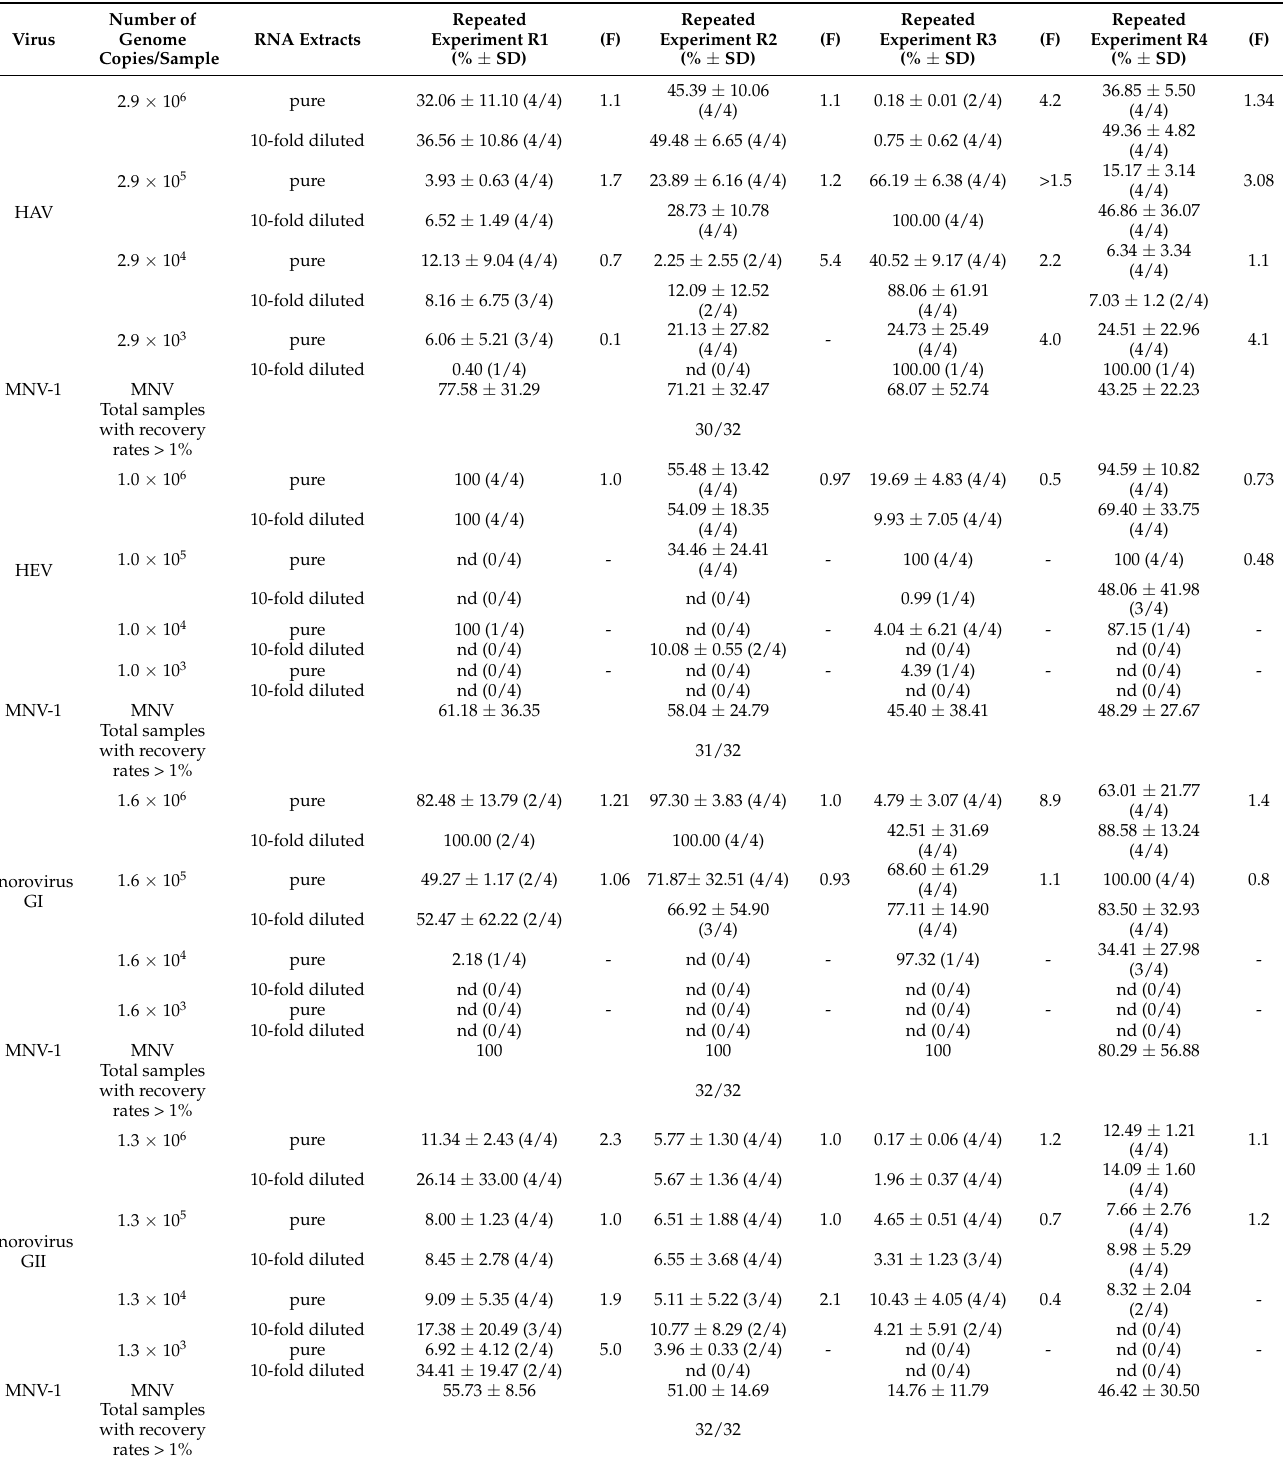
Table 4. Mean percent recovery calculated for four inoculum levels of HAV, HEV, and noroviruses in the presence of